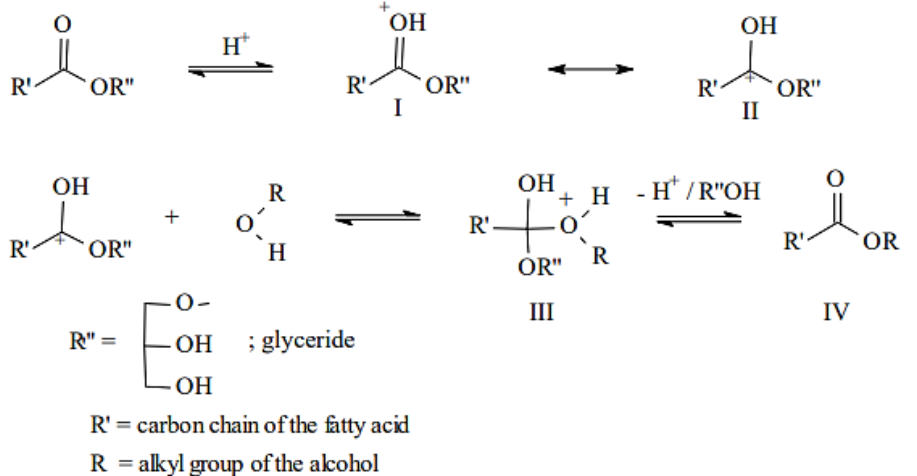
Figure 2. Mechanism of the transesterification of vegetable oils by acid catalyst [14] .